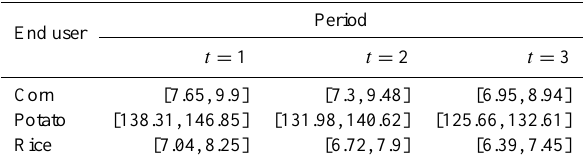
Table 4. Crop planting (km 2 ) .